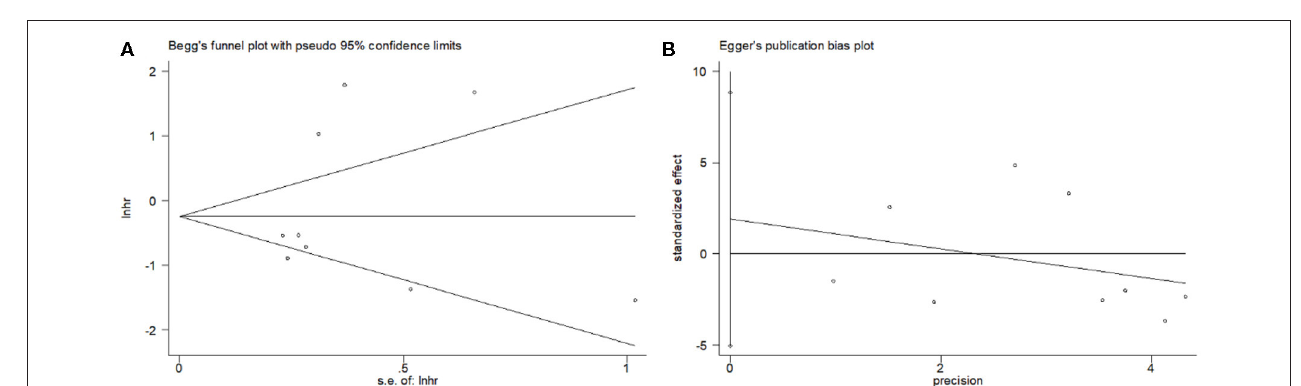
FIGURE 4 | Publication bias tested by (A) Begg’s test and (B) Egger’s test for OS.